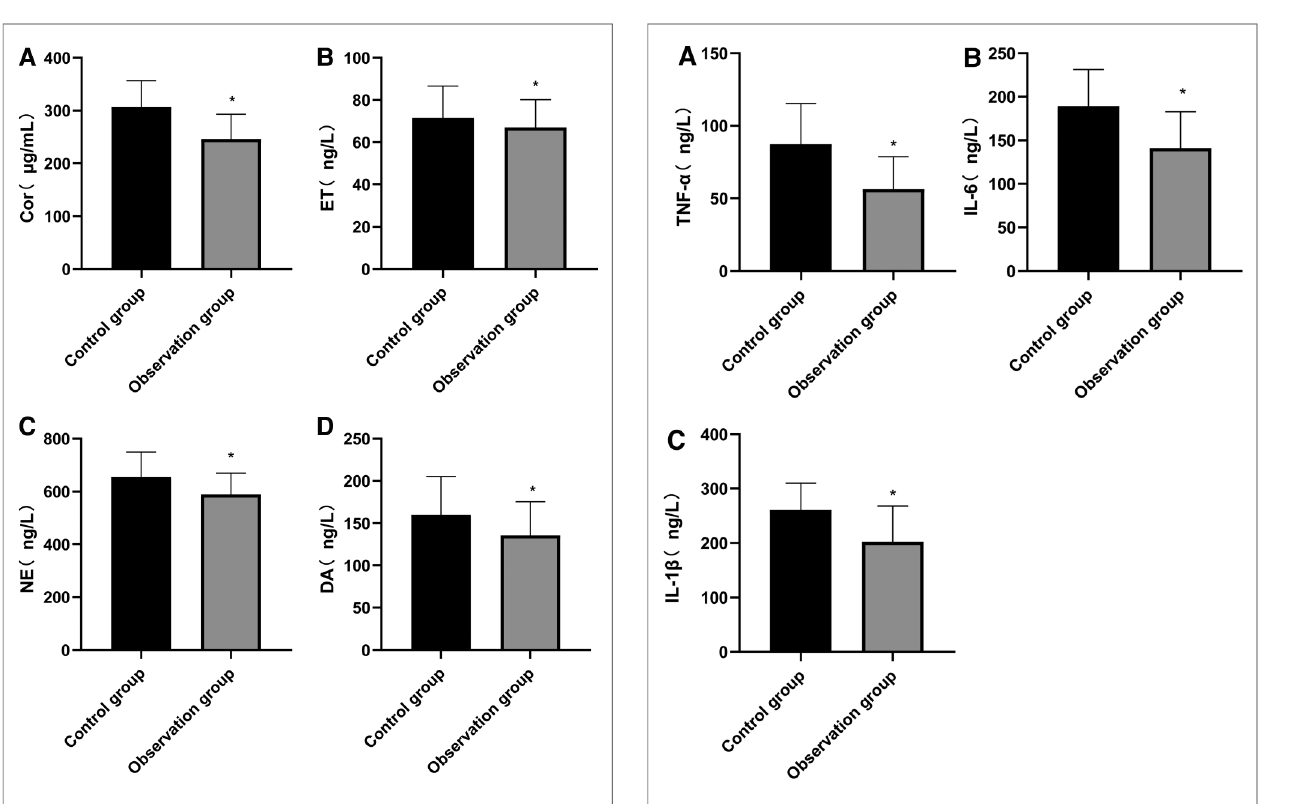
FIGURE 3 | Comparison of postoperative in fl ammatory factor level between two groups. Note: Compared with the control group, * p